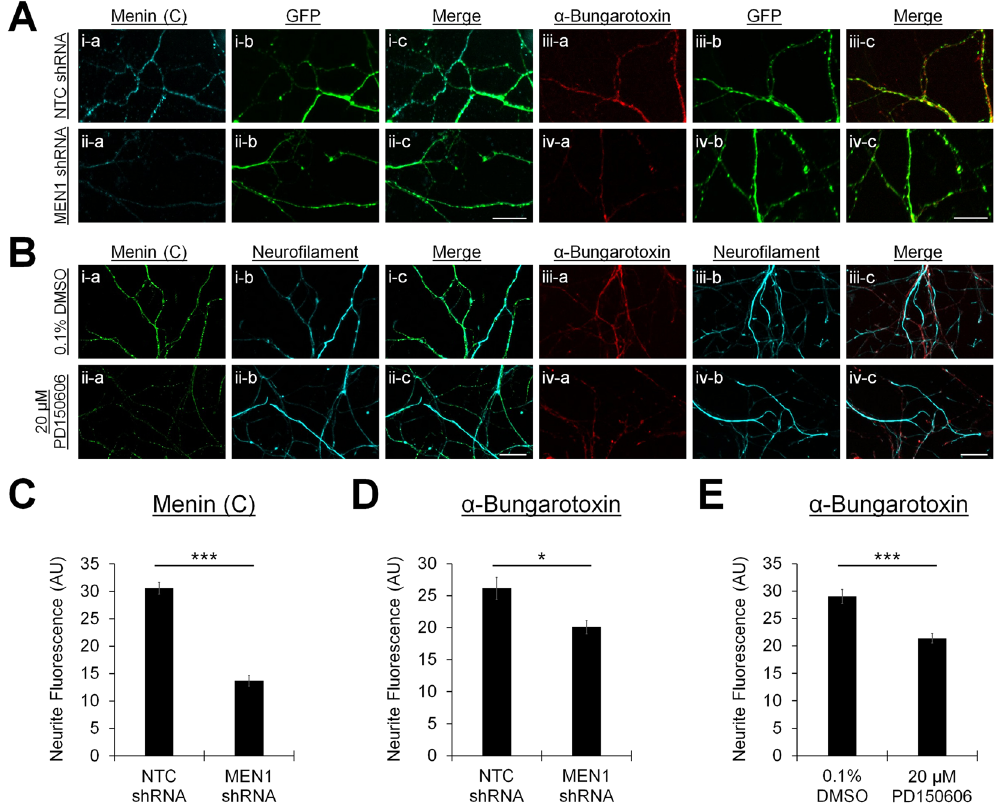
Figure 6. C-menin mediates neurite localization of α 7 subunit-containing nAChRs. ( A , B ) ICC characterization of the neurite localization of C-menin and α 7-nAChRs in NTC shRNA and MEN1 shRNA lentivirus transduced hippocampal cultures ( A ; n = 18 images, 5 independent samples each; representative images, DIV 7) or hippocampal cultures maintained in the presence of 0.1% DMSO or 20 μ M PD150606 ( B ; n = 12 images, 2 independent samples each; representative images, DIV 7). Cells were labeled with the menin C-terminal epitope antibody (i-ii-a) or fluorophore-tagged α -BTX (iii-iv-a), and neurites were visualized with GFP ( A i-iv-b) or neurofilament ( B i-iv-b) antibodies, (i-iv-c) shows merged channels. Scale bars, 20 μ m. ( C , D ) Summary data, the α -C-menin signal in neurites was reduced upon MEN1 knockdown ( C ), which coincides with a reduction of the neurite α -BTX signal ( D ). ( E ) Summary data, reduction of C-menin abundance by calpain inhibition (see Fig. 2D) coincides with a reduction of the neurite α -BTX signal (ROIs: n ≥ 36 each; see Table S5), indicating that the synaptic targeting of α 7-nAChRs requires the menin C-terminal fragment. Asterisks, statistical significance (Mann-Whitney U test); * P < 0.05. *** P <